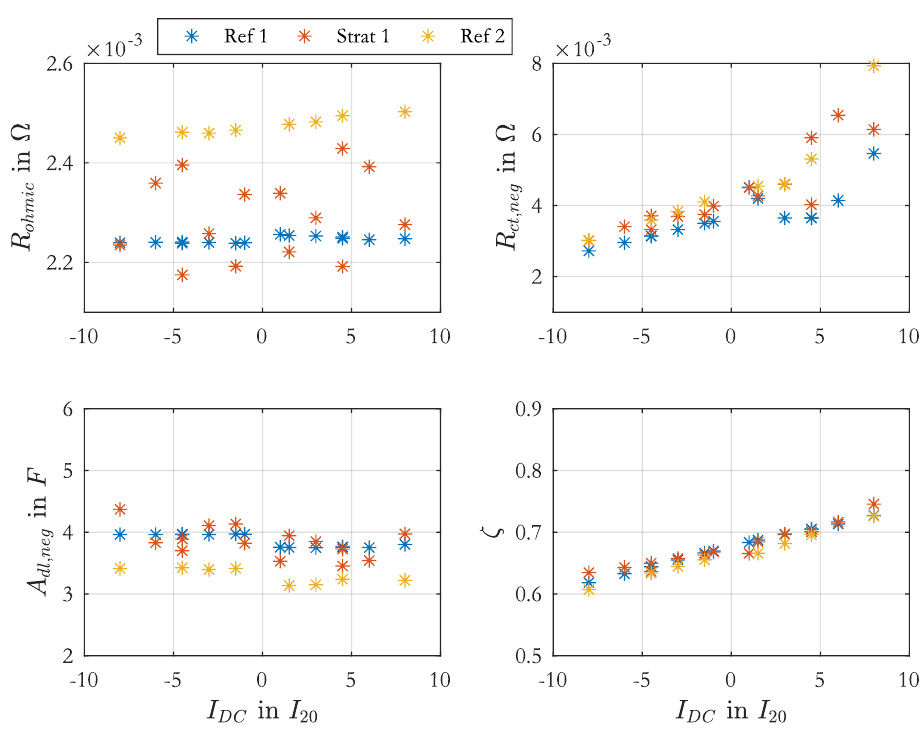
Figure 10. Fitting results of the simulated spectra during Ref. 1 , Strat. 1 and Ref. 2 using an EEC with one layer.